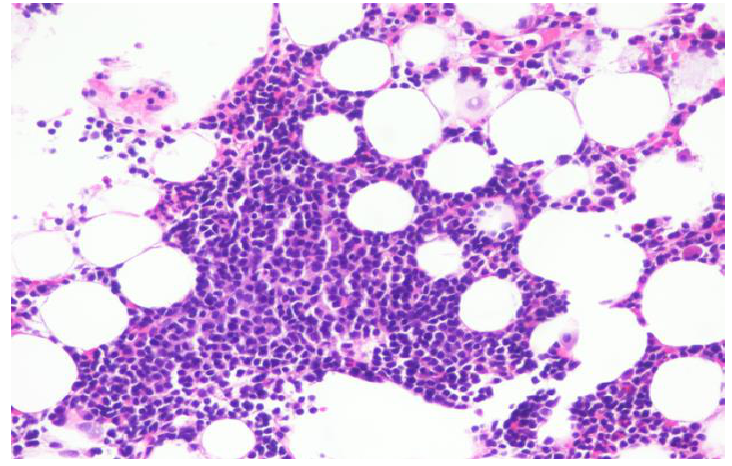
Figure 3. Hypercellular bone marrow with trilineage hematopoiesis as well as increased lymphocytes. Positron emission tomography/computed tomography showed large ascites with omental caking, exhibiting FDG activity with an SUV maximum of 3.1; it also showed mild fluorodeoxyglucose (FDG)-avid right axillary lymph nodes, but no other evidence of the recurrence of CLL (Figure 4).